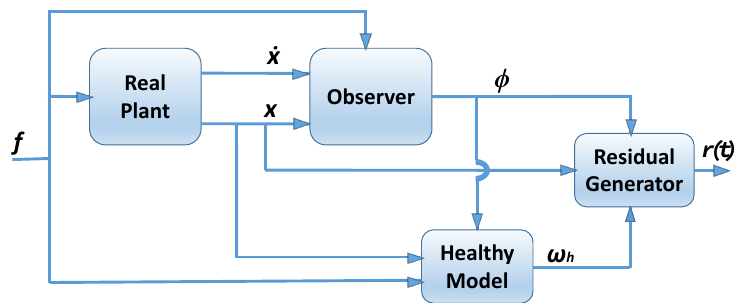
Figure 13. Block diagram representation of model-based fault diagnosis